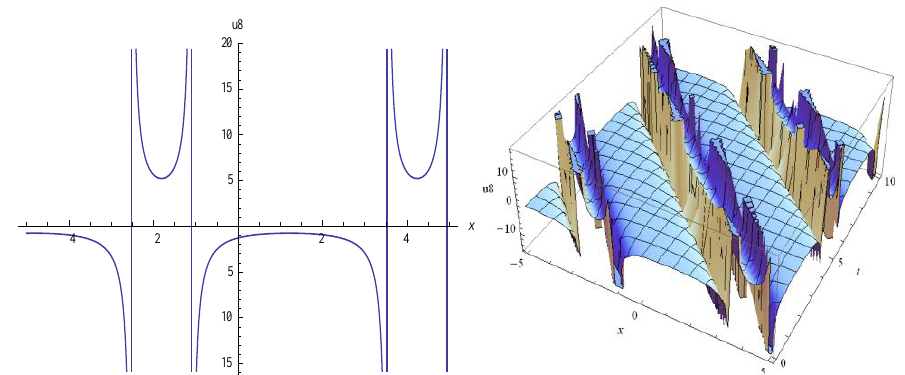
Figure 3. Dark soliton solution (36) of Equation (1) and its projection at 𝑡 = 0 when 𝜇 = 0.4,𝜆 = 0.5, 𝐴 1 = 0.2,𝐴 2 = 0.1 .